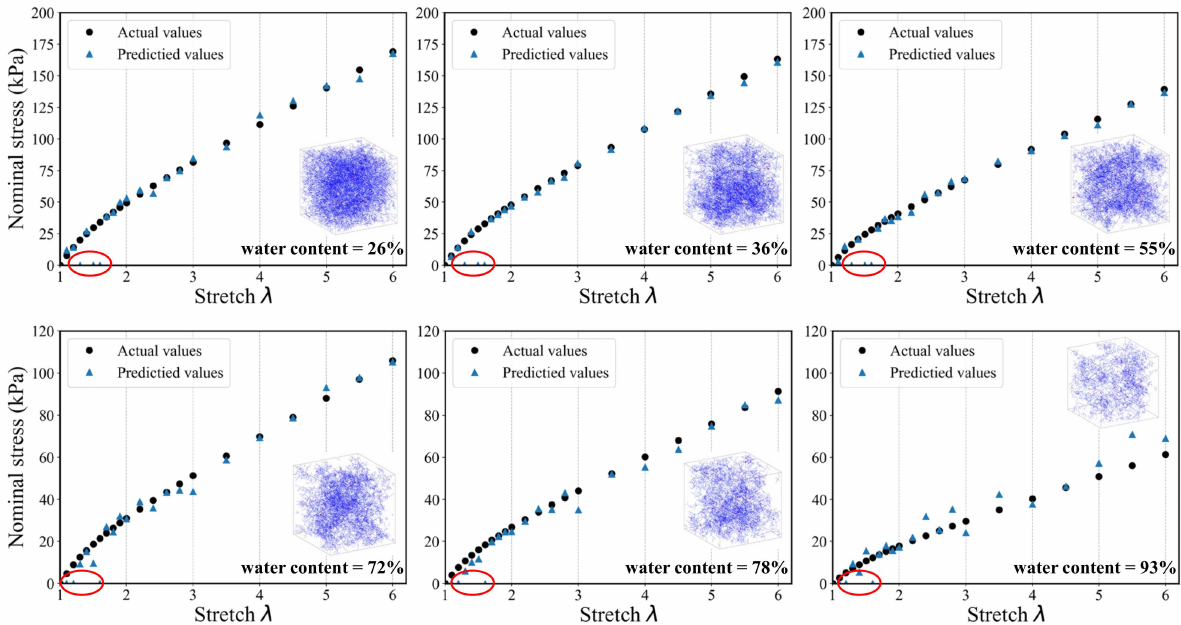
Figure 14. A randomly generated set of six SAW models and corresponding stress–stretch curves for the DNN model prediction compared to the actual results. (The data points in the red circle represent prediction distortion).